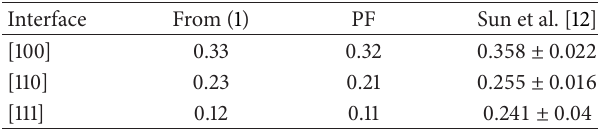
Table 1: Kinetic coefficient of Ni in m/sK from molecular-dynamics simulations and phase-field